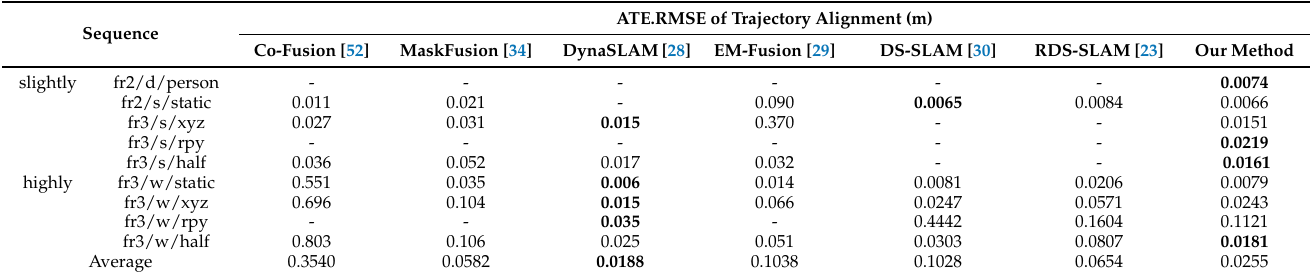
Table 4. The ATE.RMSE on the TUM benchmark, compared with the V-SLAM methods based on deep